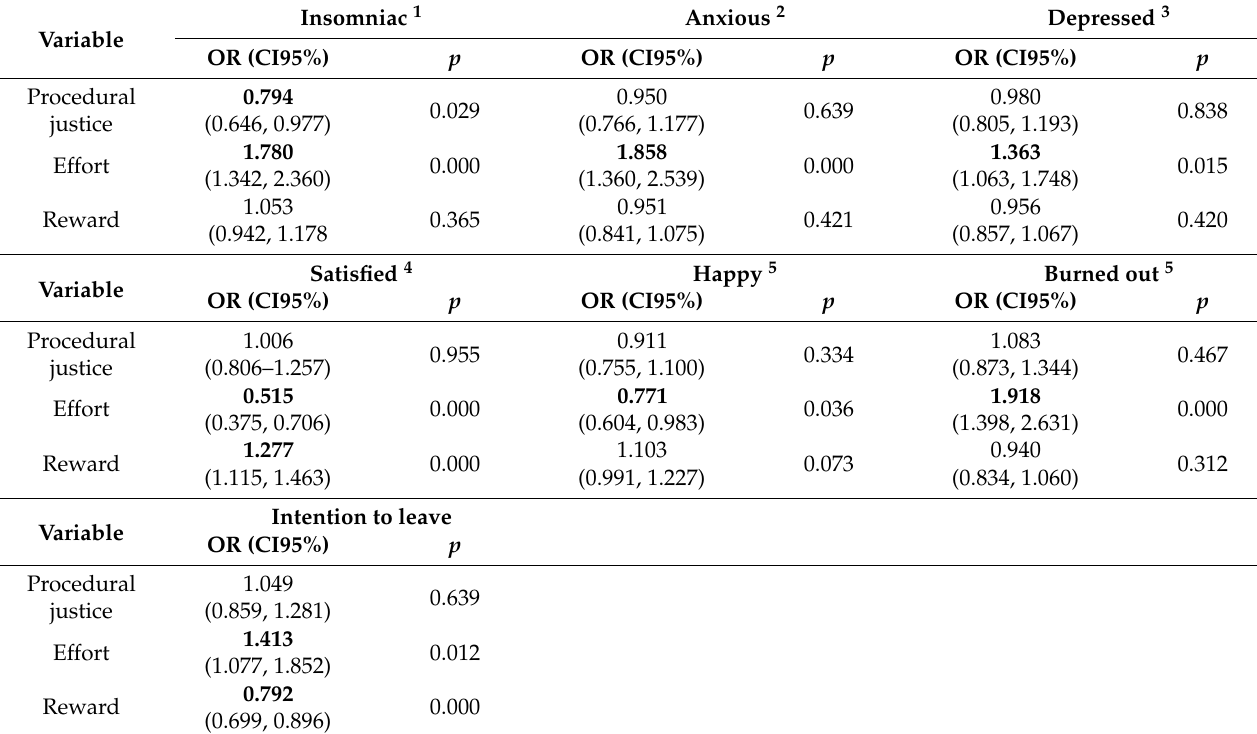
Table 6. Second wave. Health outcomes associated with procedural justice and occupational stress. Multivariate logistic regression model adjusted for age and